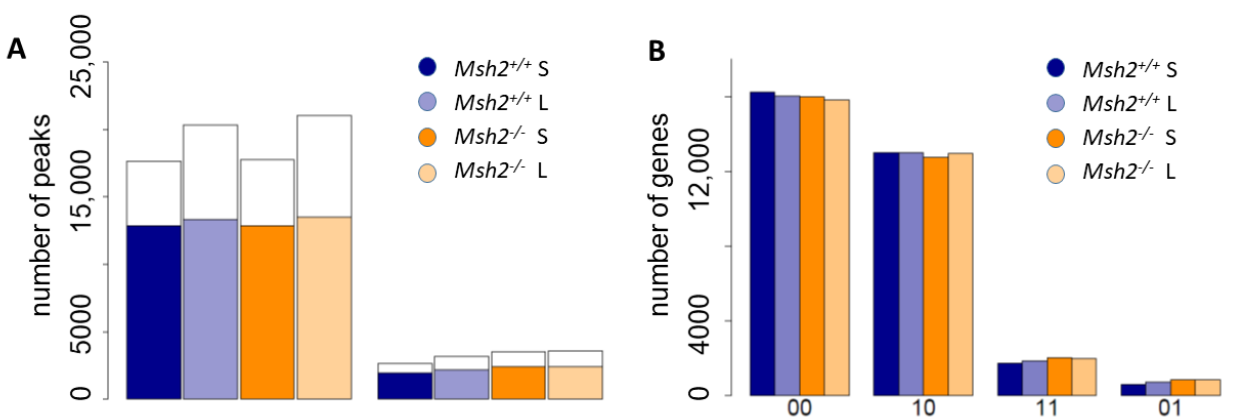
Figure 1. Histone ChIP-seq data. ( A ) Bar plots of the total number of quality peaks ( left : H3K4me3; right : H3K27me3) and the fraction of these peaks associated with the genes (colored parts) for organoids derived from Msh2 +/+ and Msh2 −/− mice. Short-term (S) and long-term (L) organoids are compared. ( B ) Distribution of the modification states (H3K4me3 and H3K27me3) among the genes.